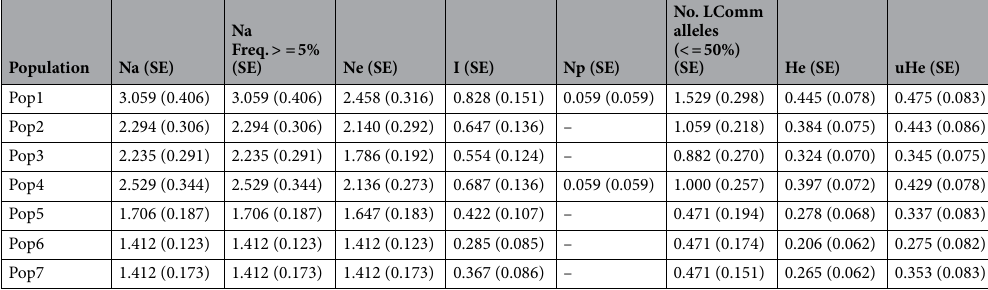
were comparable to the average number of alleles. The gene diversity ( He ) and uHe values ranged from 0.206 to 0.445 and 0.275 to 0.475 respectively. Also, Shannon’s information index (I) was calculated for populations with the highest diversity found in Pop1 (I = 0.828, SE = 0.151) and lowest in Pop6 (I = 0.285, SE = 0.085). Clustering and principal coordinate analysis (PCoA). To understand the patterns of variations of genetic diversity by SSR data, two multivariate methods were employed; clustering and principal coordinate analysis.